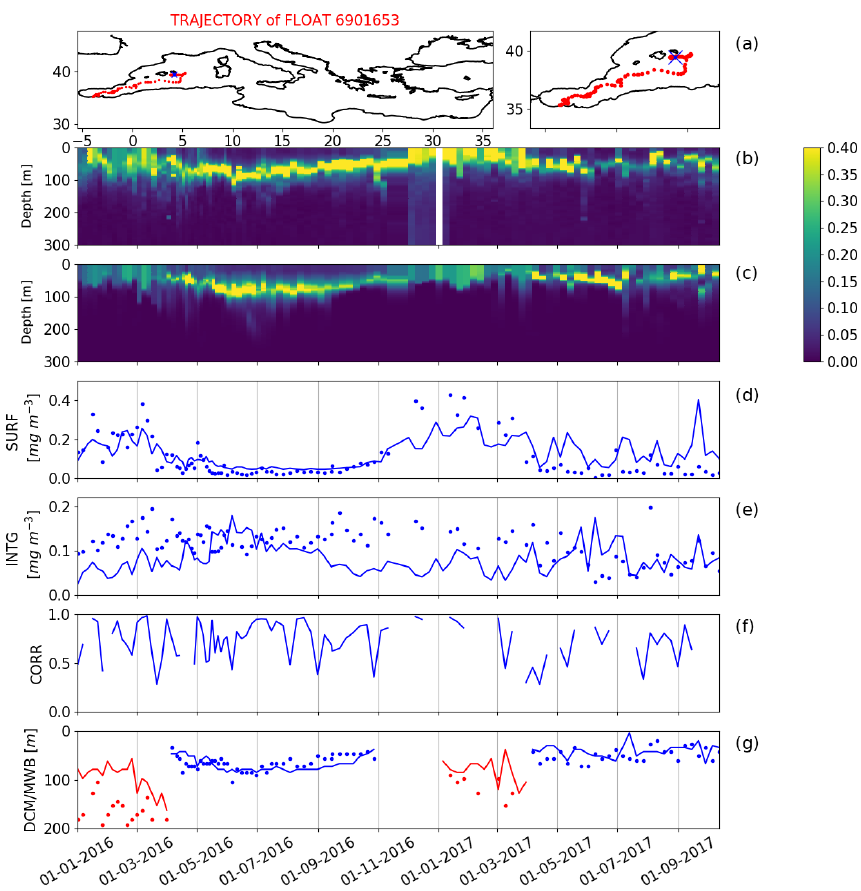
Figure 9. Time evolution of BGC-Argo float 6901653. (a) Trajectory of the BGC-Argo float (red dots) with deployment position (blue cross); Hovmöller diagrams of chlorophyll concentration (mgm 3 ) from float data (b) and model outputs (c) matched-up with float position for the period 2016–2017. Computation of selected skill indexes for model (solid line) and float data (dots): surface chlorophyll (SURF, d ) and 0–200m vertically averaged chlorophyll (INTG, e ), correlation between vertical profiles (CORR, f ), depth of the deep chlorophyll maximum (DCM, blue), and depth of the mixed layer bloom in winter (MWB, red; g